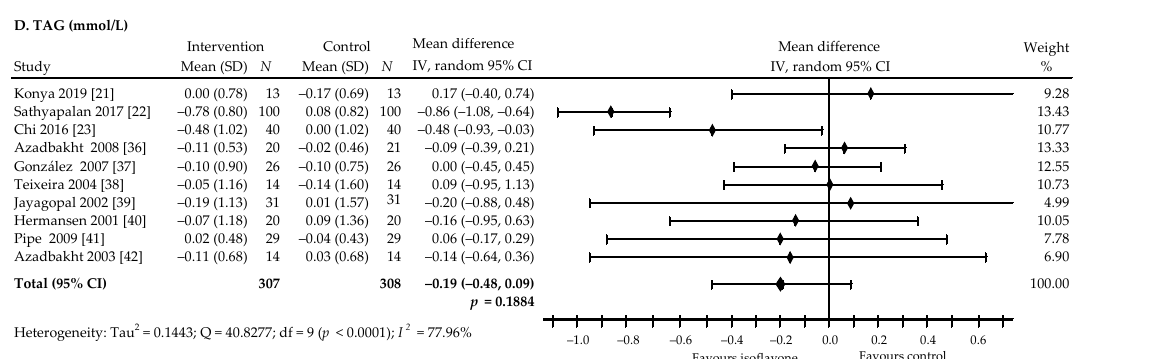
Figure 5. Forest plots showing the difference in lipid-profile components in all trials between soy isoflavone-administered and control groups. ( A ): TC, ( B ): LDL-C, ( C ): HDL-C, ( D ): TAG. Data calculated from the random-effects model are presented as weighted mean difference and 95% CI. The horizontal lines denote the 95% CIs, some of which extend beyond the limits of the scales. Begg’s and Mazumdar rank correlation test indicated no evidence of publication bias for TC (Kendall’ s tau = ‒0.1556; z = ‒0.6261; p = 0.53), LDL-C (Kendall’ s tau = ‒0.0667; z = ‒0.2683, p = 0.7884), HDL-C (Kendall’ s tau = ‒0.0222, z = ‒0.0894, p = 0.93) and TAG (Kendall’ s tau = ‒0.1429, z = ‒0.4949, p = 0.62). Moreover, the results of Egger’s test for regression revealed no evidence of publication bias for TC, LDL-C, HDL- C and TAG: ‒